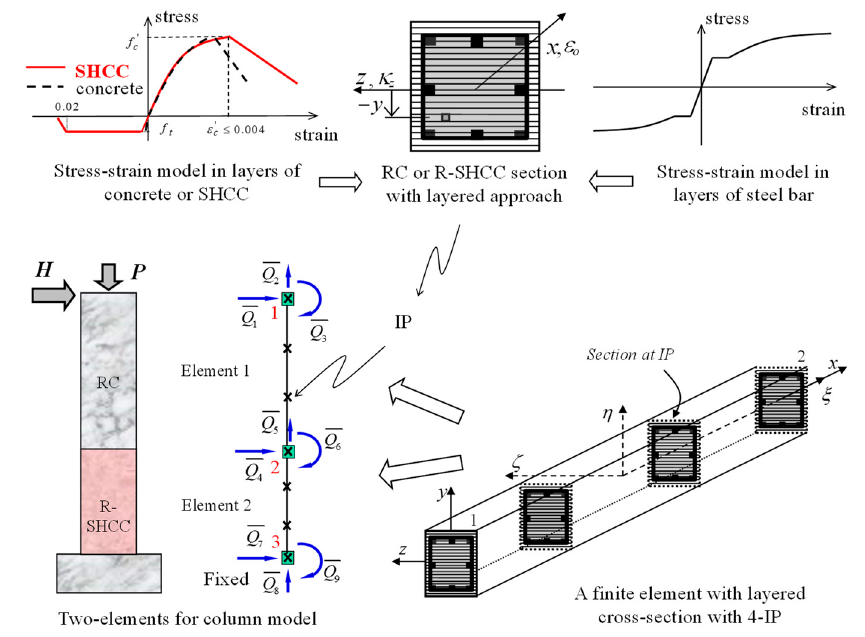
Figure 8. Isoparametric frame finite element and modeling of column specimens. As uniaxial laws, concrete and reinforcing steel bars were adopted as well-known stress and strain models [20,21], but SHCC after cracks had taken place in tension the tensile stress was sustained until the corresponding tensile strain reached to 2.0%, as